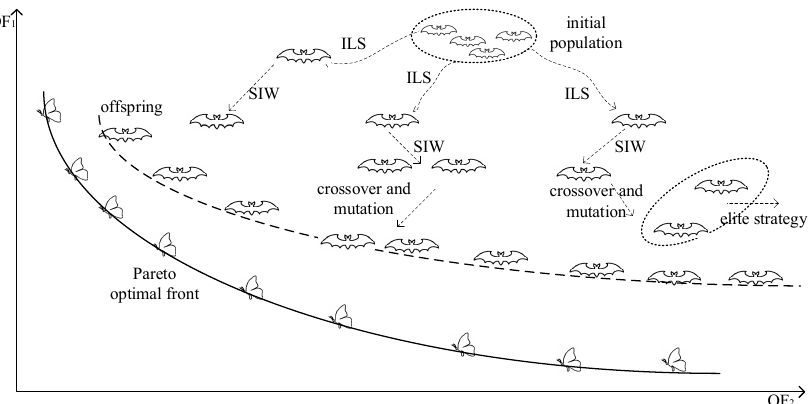
Figure 2. The main idea of an improved bat algorithm based on non-dominated sorting (NSIBA).